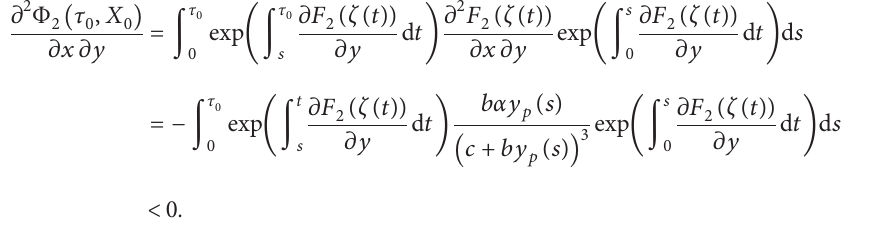
Figure 4: Two coexisting attractors of model (1) with λ conditions are as follows: ( A − B )( x